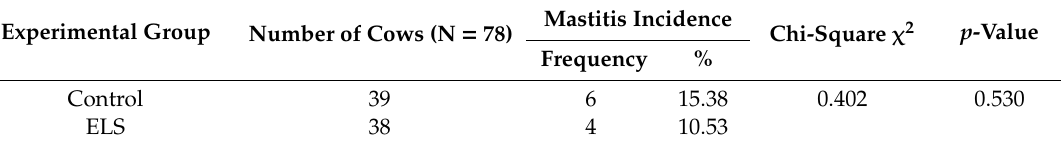
Table 7. Clinical mastitis incidences in Holstein dairy cows fed diets supplemented with